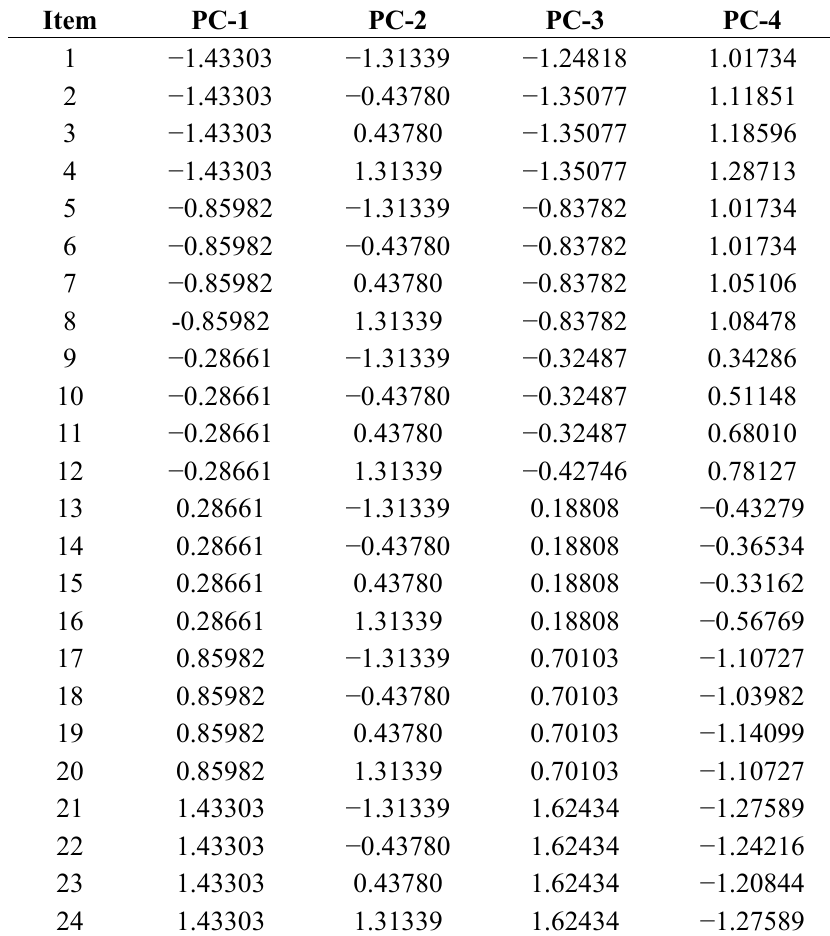
Table 6. The standardized processing of index